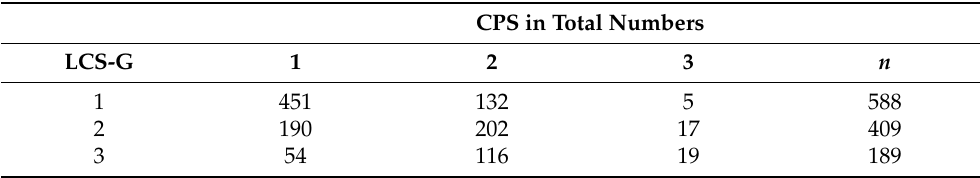
Table 6. Distribution of CPS according to LCS records; LCS-G 1–3: LCS-G 1–3: locomotion score groups 1 to 3; CPS: claw-position